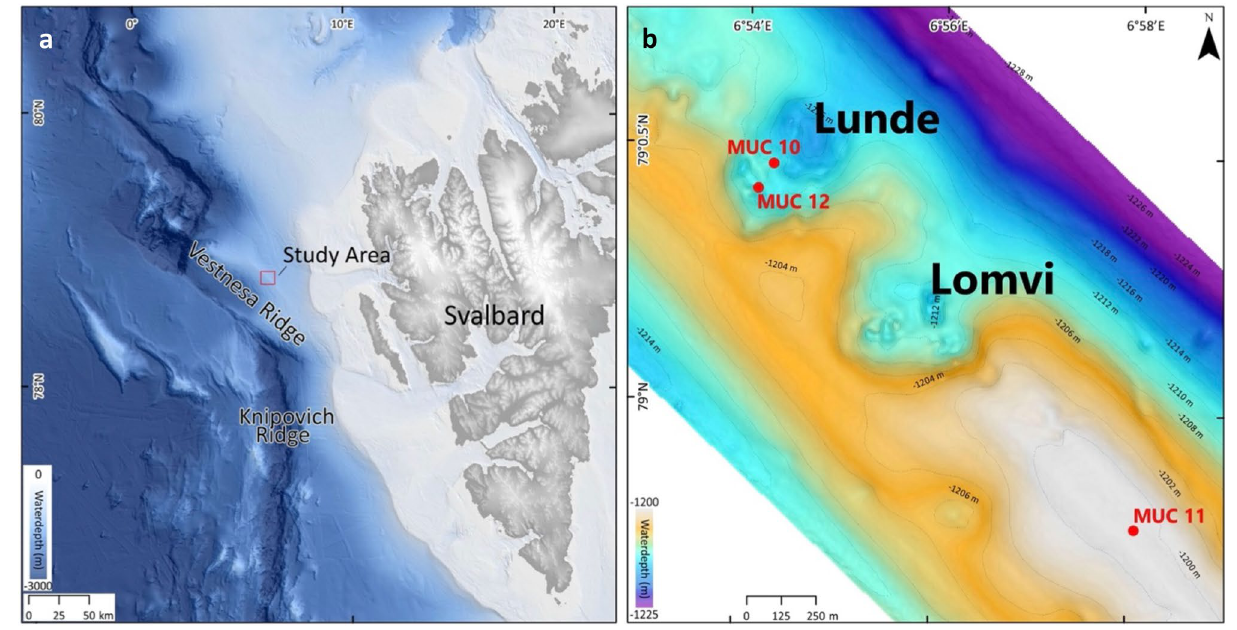
Figure 1. ( a ) Svalbard margin in the Eastern Fram Strait (bathymetry from Jakobsson et al. 33 ). ( b ) Detail of Vestnesa Ridge (modified from Bünz et al. 23 ). Red dots indicate multicorer locations: Siboglinidae field (MUC 10), bacterial mats field (MUC 12), and control site (MUC 11). This figure is original, made using ArcMap v10.6. https:// www. esri. com/ en- us/ arcgis/ produ cts/ arcgis- deskt op/ overv